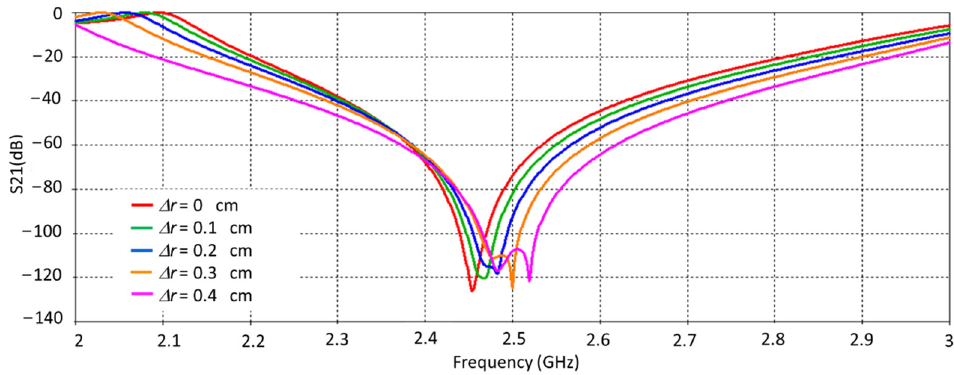
∆ r) from its ideal